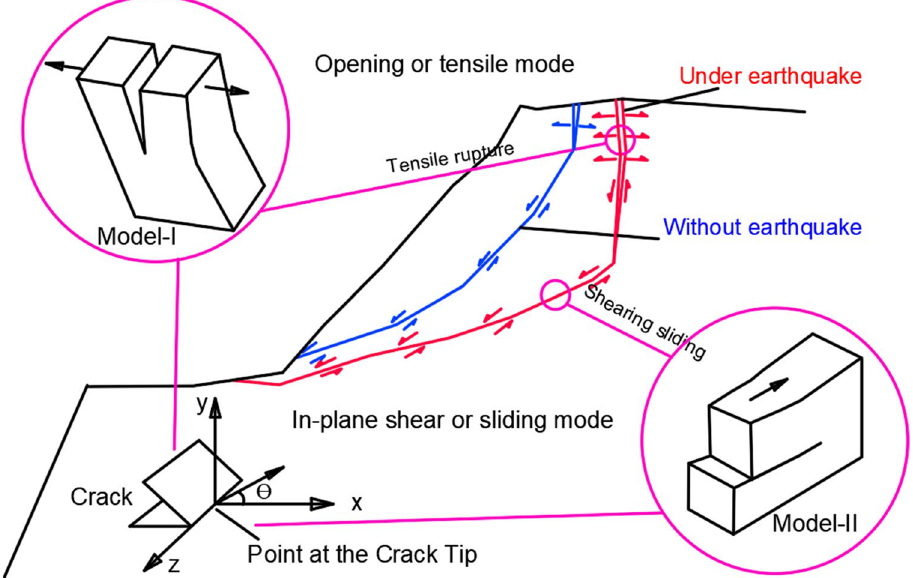
Figure 1. Schematic of the different sliding surfaces under static and earthquake loading conditions. Tensile rupture fractures are observed at the top of the slope under earthquake loading condition and sheared sliding is formed after tensile rupture. The stress loading modes and crack coordinates system are also